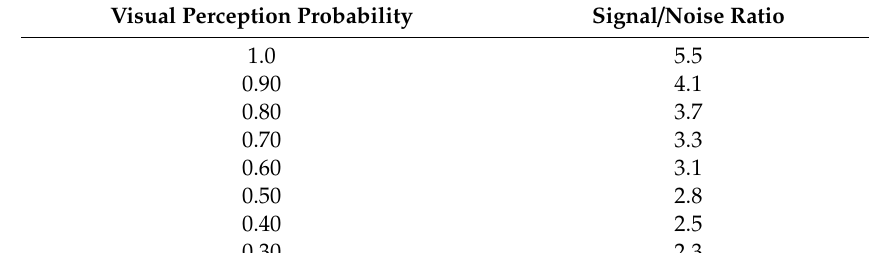
Table 4. Visual data perception probability and required minimal signal to noise value.